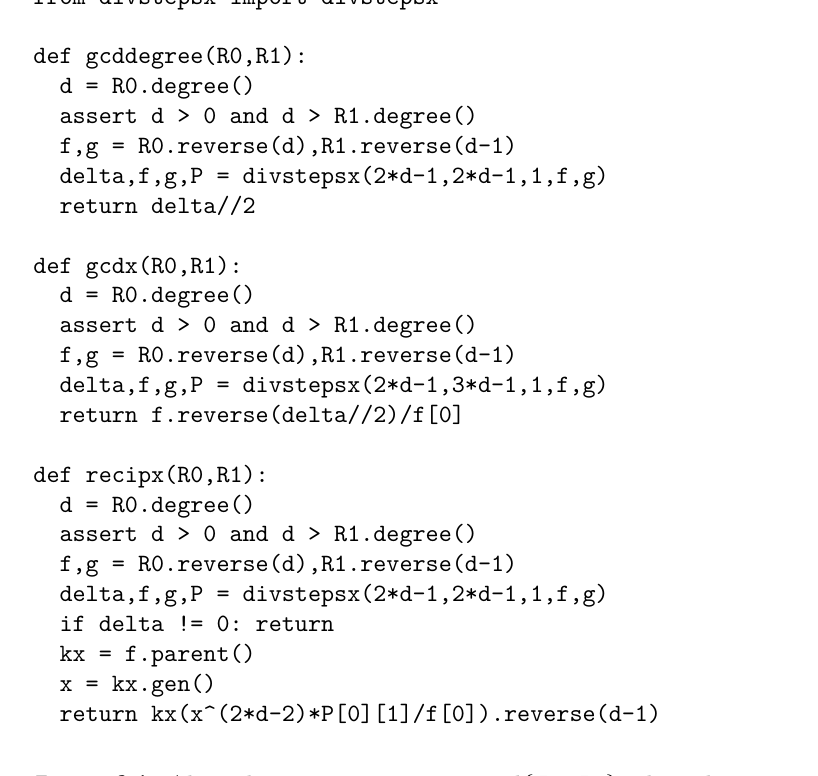
Figure 6.1: Algorithm gcdx to compute gcd { R 0 , R 1 } ; algorithm gcddegree to